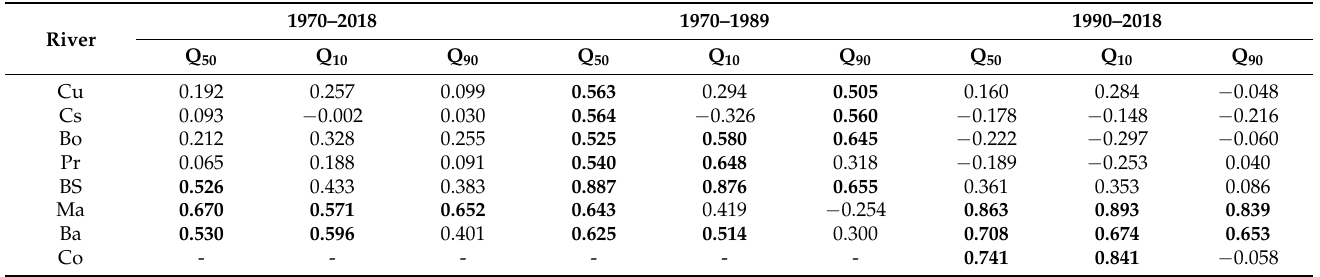
Table A2. Adjusted R 2 of the third-order models predicted by Niño 3.4 and DMI in SON a set in three different periods. The values higher than 0.5 are bolded, indicating good model skill.